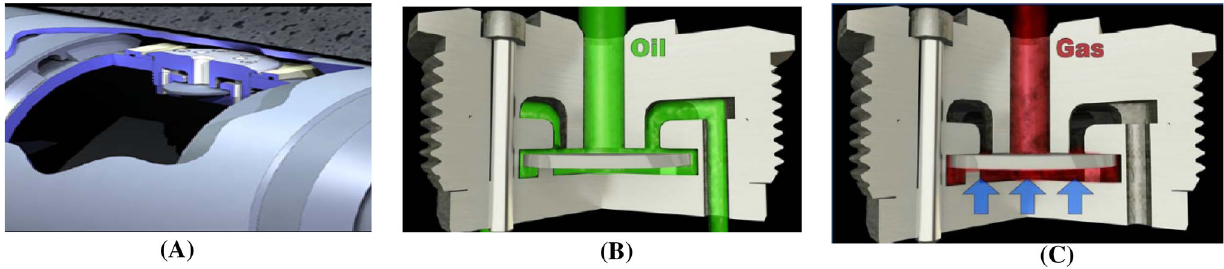
Fig. 6 Expanded view of RCP insert in base pipe Movement of the RCP internal disk under oil and gas flow conditions (Halvorsen et